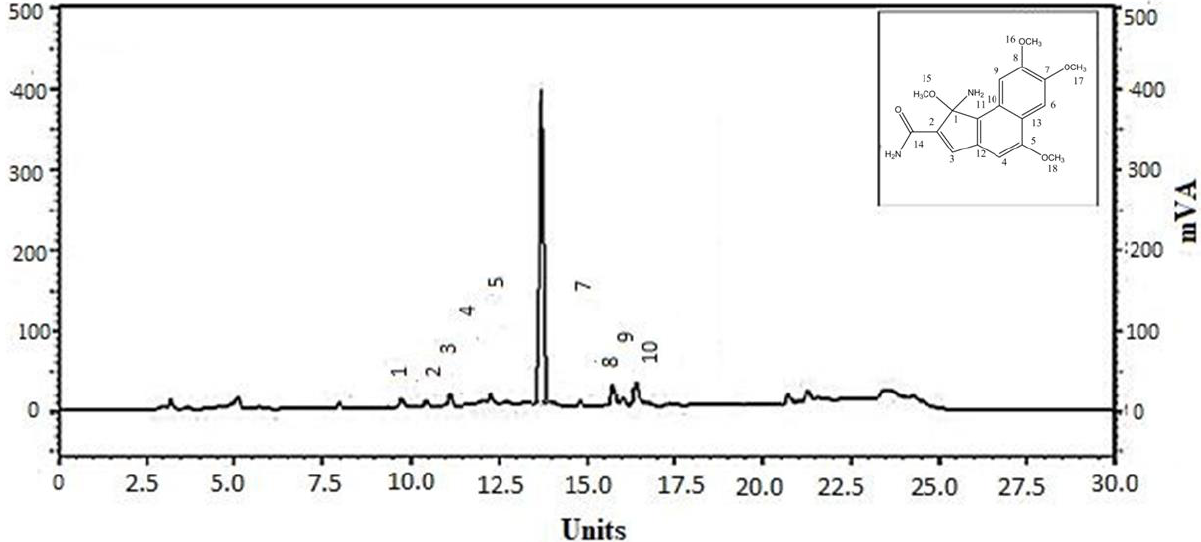
Figure 2. HPLC chromatogram and chemical structure of isolated compound of C. lancifolius “LFD”. HPLC data showed a single prominent peak of LFD.